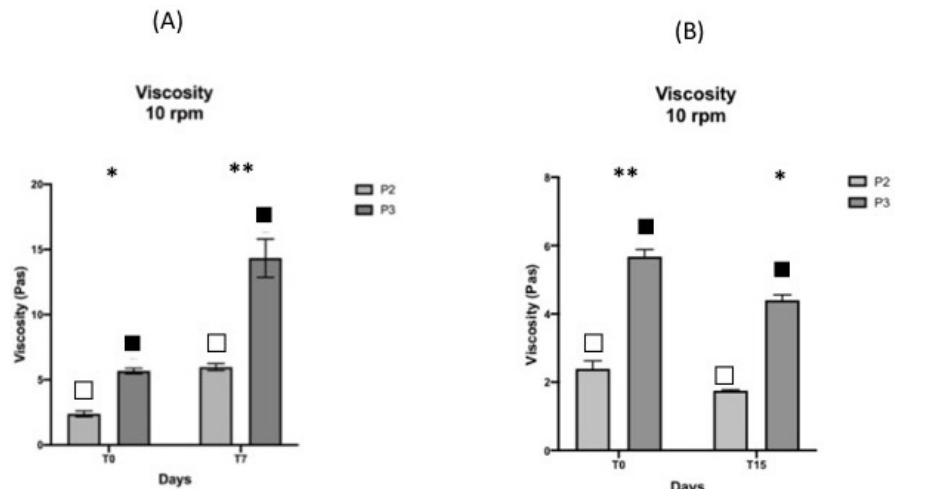
Figure 4. Viscosity values before and after storage for 7 days at 0 ± 2 ◦ C ( A ) and before and after hot storage for 15 days at 52 ± 2 ◦ C ( B ). Values are expressed as the mean ( ± SD) of sample replicates ( n = 3). ( ∗ ) and ( ∗∗ ) indicate the difference among the products at the two endpoints, T0 and T7 respectively. Different symbols indicate the differences among the values in the two products ( p ≤ 0.05).